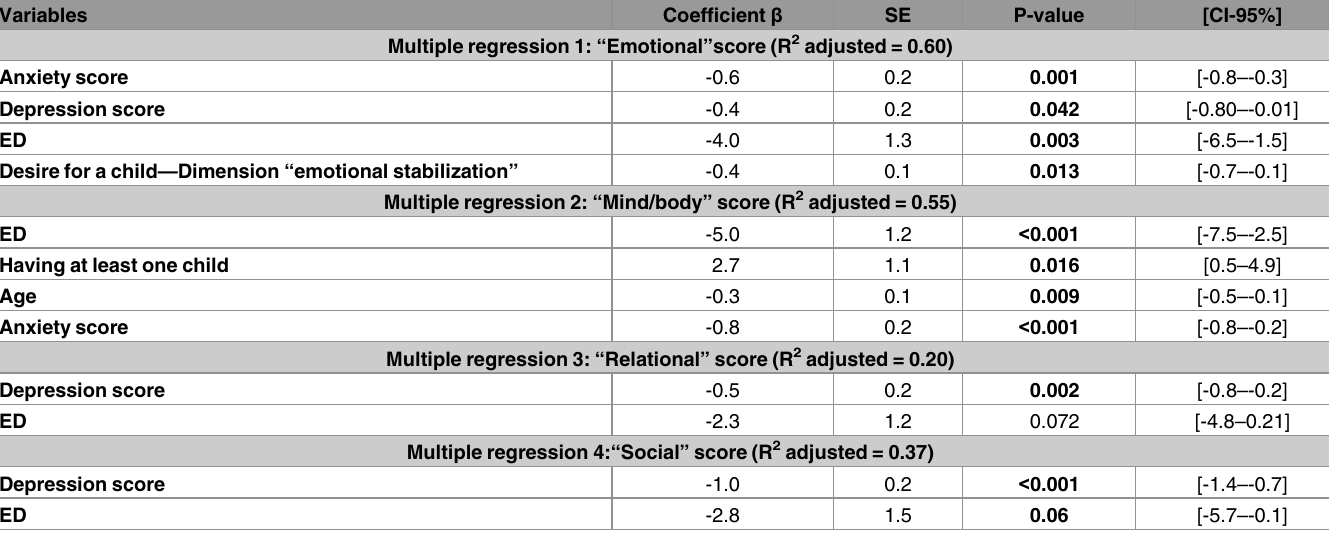
Table 4. Multiple regressions based on the quality of life in infertile women assessedwith the questionnaire FertiQoL (four dimensional